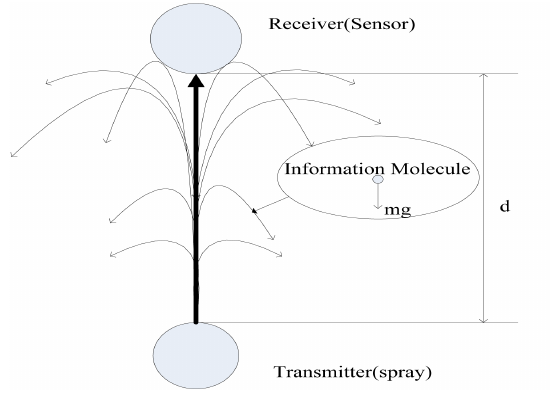
Figure 2. The vertical model of